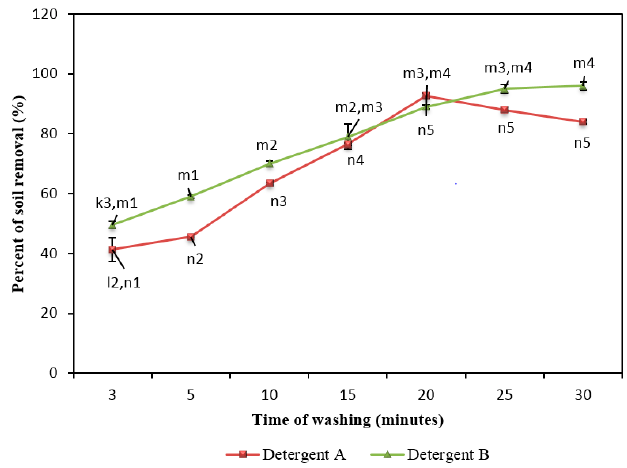
Figure 4. Effect of washing time on soil removal using the formulated detergent A (contained free enzymes) and B (contained encapsulated enzymes) in hard water (350 ppm CaCO 3 ) at 50 °C. Note: Superscripts m2, m3 and m4 (test for detergent A) indicated groups that showed significant difference between the groups when washings were done. Superscripts n2, n3, n4 and n5 (test for detergent B) indicated groups that showed a significant difference between the groups when washings were done. All superscripts were obtained using post-hoc tests as shown in Table S4. Data are means ± standard deviation of three determinations and indicated as error bars.